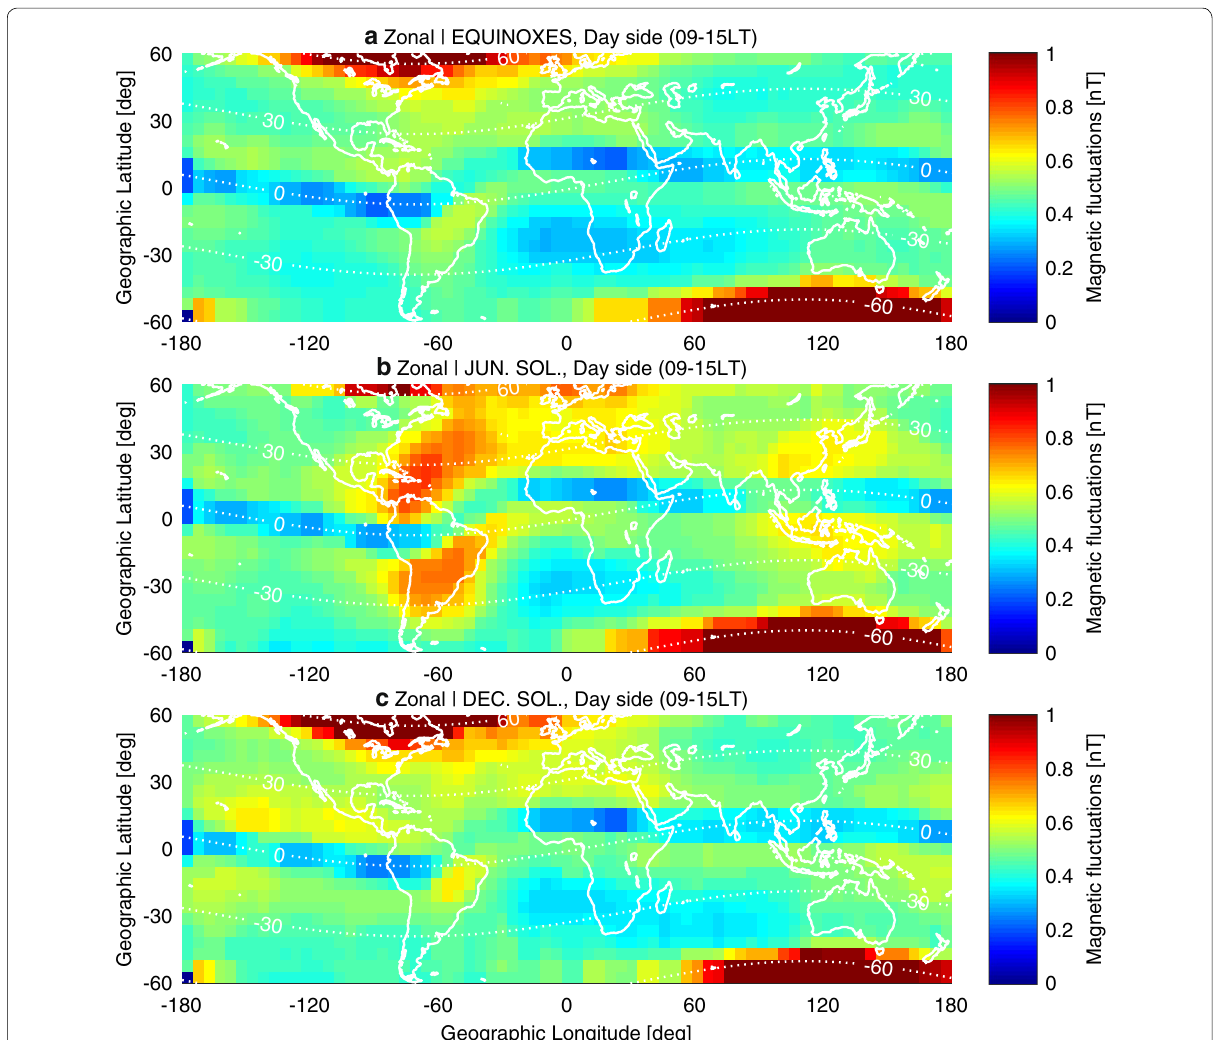
Fig. 2 Seasonal dependence of the MR amplitude distribution of the zonal component on the day side (9–15 LT). a Combined equinox, b June solstice and c December